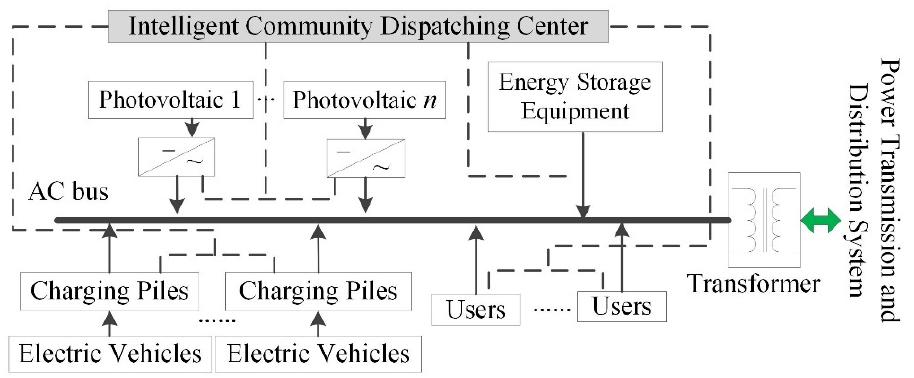
Figure 1. Microgrid system of intelligent residential area.